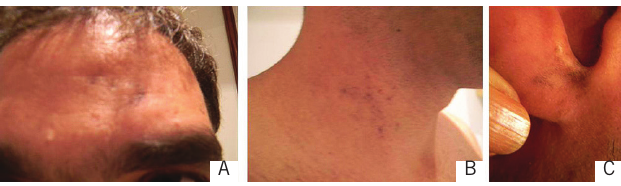
figurE 3 − Case 2: A) greyish brown plaque 3 × 2 cm on the left forehead; B) an ill- defined plaque on the right neck studded with numerous 2-3 mm black papules; C) brown papules and macules on the right ear lobe